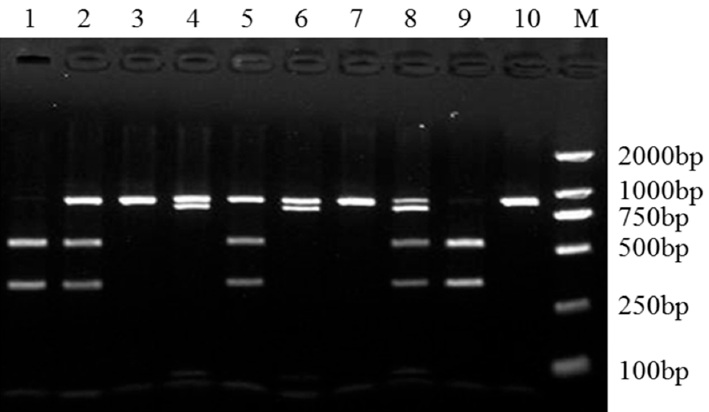
Figure 3. The PCR-restriction fragment length polymorphism (PCR-RFLP) results for the different genotypes of sheep SPP1